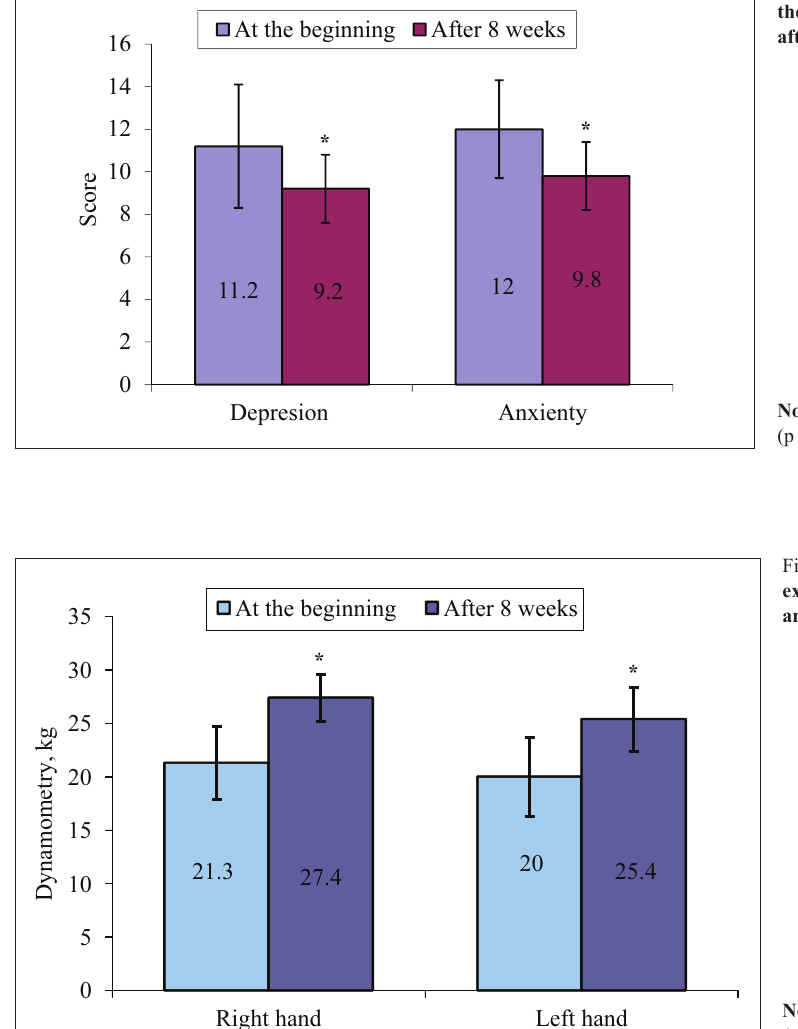
Note. * – statistically significant difference (p <